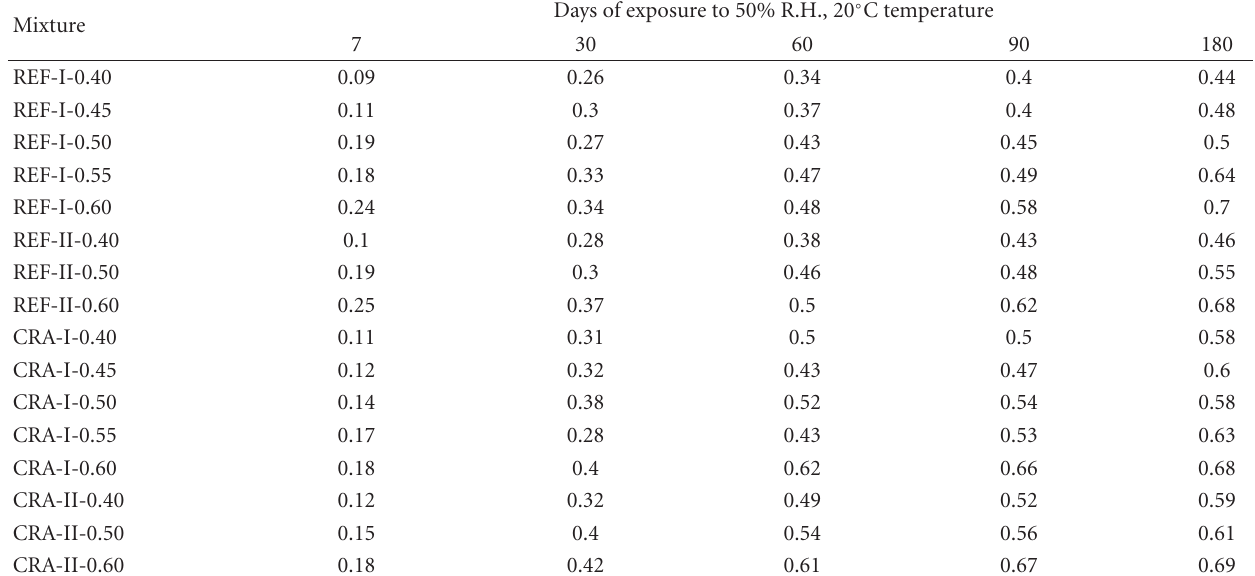
Table 5: Drying shrinkage measurements (mm/m).